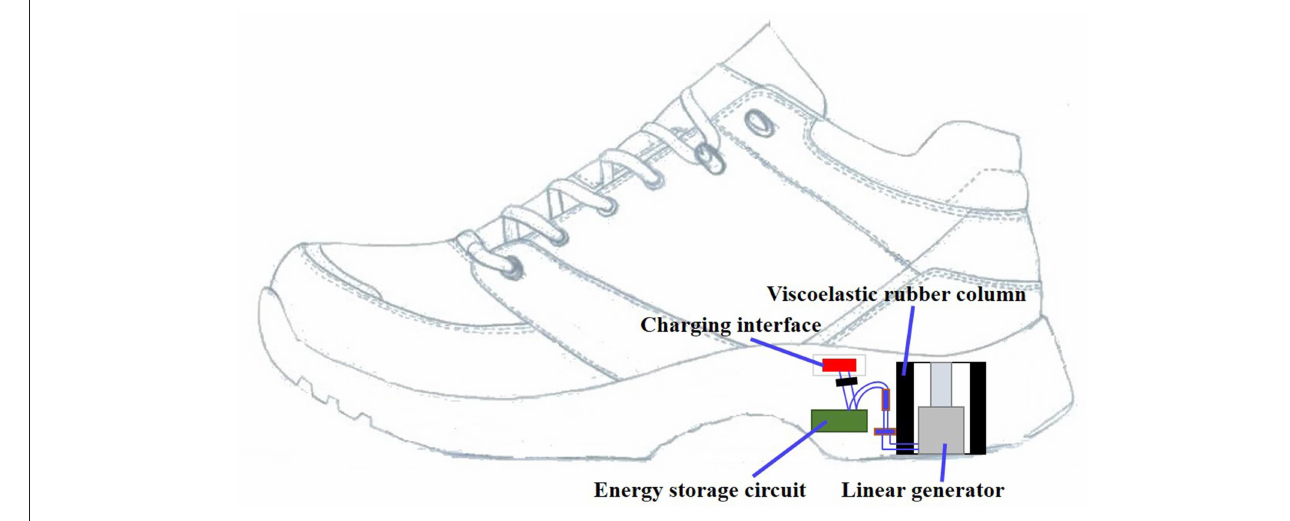
FIGURE 1 | The multi-functional shoe.